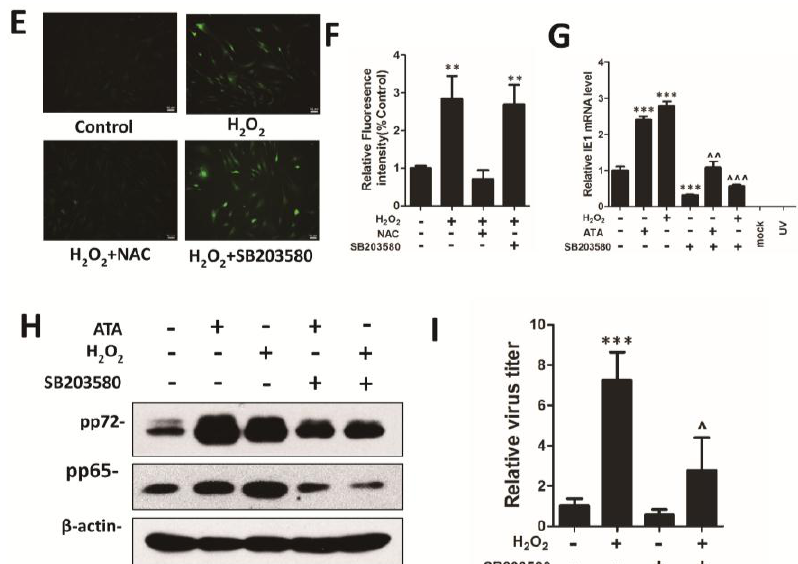
Figure 6. H O facilitates HCMV replication by activating the p38-MAPK pathway. HFF 2 2 Figure 6. H 2 O 2 facilitates HCMV replication by activating the p38-MAPK pathway. cells were left untreated or were treated with 200 µ M H HFF cells were left untreated or were treated with 200 μM H 2 O 2 for the indicated times ( A ) with various H O concentrations for 6 h ( B ). The kinases were detected by Western blotting, 2 2 or with various H 2 O 2 concentrations for 6 h ( B ). The kinases were detected by Western using specific primary antibodies against phospho-p38 and p38 and β -actin to calibrate blotting, using specific primary antibodies against phospho-p38 and p38 and β-actin to sample loading. HFF cells were treated with SB203580 (10 µ M) or NAC (5 mM) 1 h prior calibrate sample loading. HFF cells were treated with SB203580 (10 μM) or NAC (5 mM) to H O (200 µ M) and ATA (5 mM) stimulation. Cells were harvested at 6 h post H 2 2 and ATA treatment ( C , D ). Cells were determined by staining ( E ) or by measuring ( F ) the fluorescence produced after a 30 min incubation at 37 ◦ C with 10 µ M H were infected with UV-HCMV (UV) or HCMV at an MOI of 0.5. Real-time PCR analysis of IE1 mRNA levels in cells allowed comparisons to untreated cells. Total mRNA was extracted from HFF at 24 h post infection. At 72 h, pp72 and pp65 protein were detected by Western blotting ( H ). Viral titer was detected in the presence or absence of H